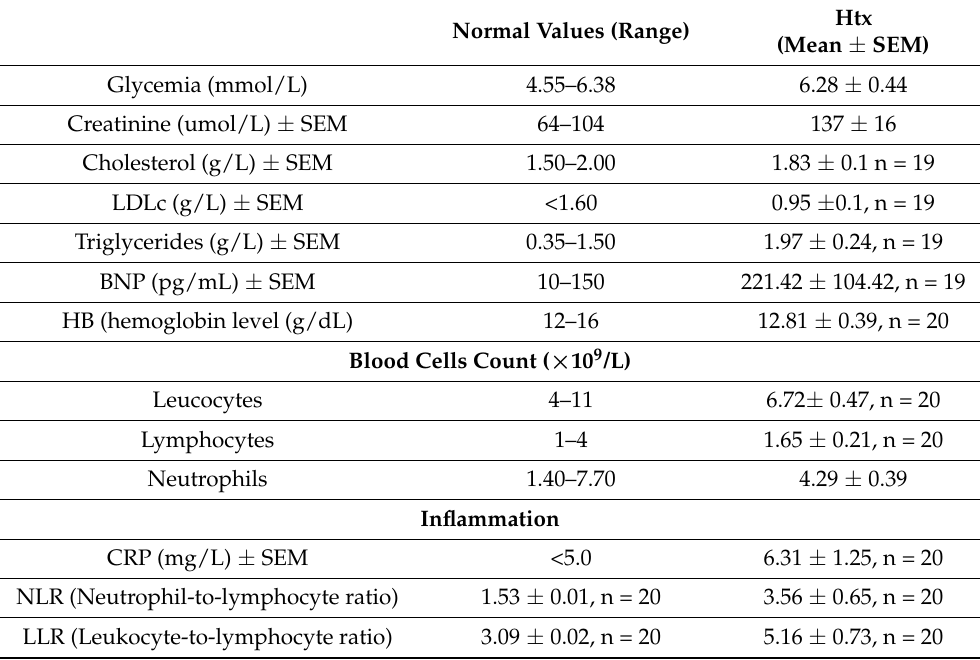
Table 2. Biological characteristics of the heart transplanted patients.